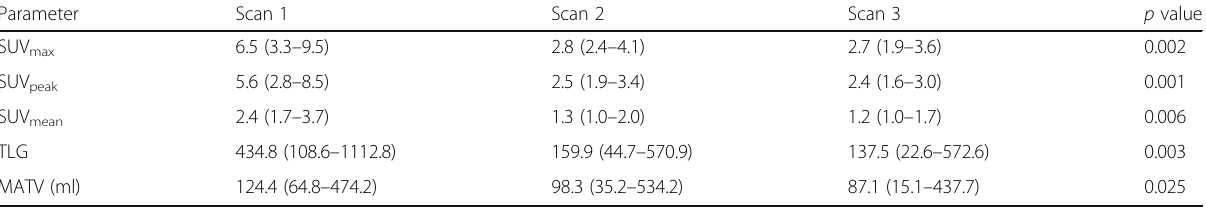
Table 3 Metabolic tumor activity for the VOI man for the serial 18 F-FDG PET-CT scans